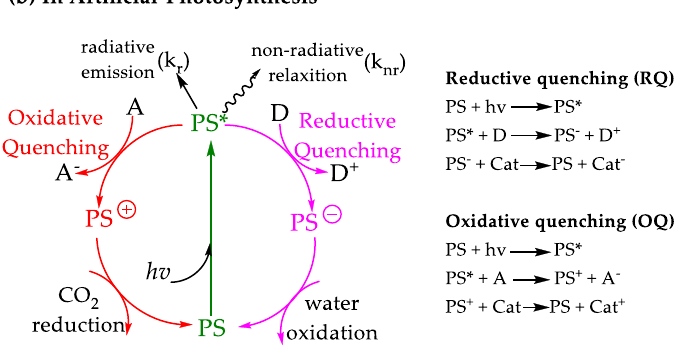
Figure 2. ( a ) The Z-scheme coupling PSI and PSII in natural photosynthesis; ( b ) the general scheme of the quenching pathway in photocatalytic reactions. PS: photosensitizer; A: electron acceptor; D: electron donor; Cat: catalyst. *: excited state.